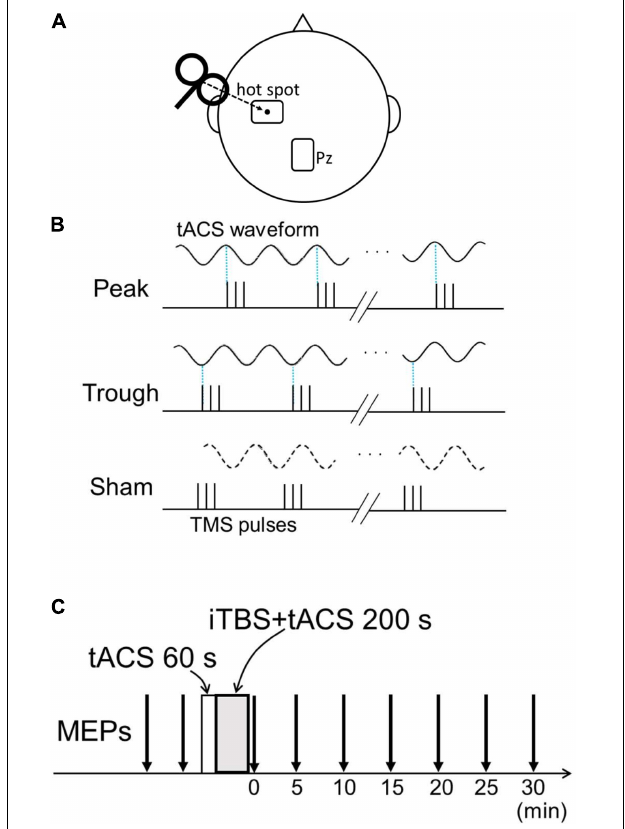
FIGURE 1 | Experimental setup. (A) Transcranial alternating current stimulation (tACS) electrode position and transcranial magnetic stimulation (TMS) coil configuration. The target electrode was placed over the left M1 “hot spot,” and TMS was delivered over the target electrode. The reference electrode was placed over Pz. (B) Three conditions for the combined tACS/ intermittent theta-burst stimulation (iTBS) pulses. On the basis of the tACS phase, the first of the three pulses was adjusted to 90 ◦ for the peak condition and to 270 ◦ for the trough condition. For the sham condition, tACS only lasted 20 s and was terminated before iTBS began. Thus, no tACS current flowed during iTBS. (C) Time course of the experiment. Baseline motor evoked potentials (MEPs) were obtained from two sessions comprising the recording of 24 MEPs before the combined stimulation. tACS began before iTBS and continued after iTBS onset for 200 s. After the intervention, 24 MEPs were recorded every 5 min for 30